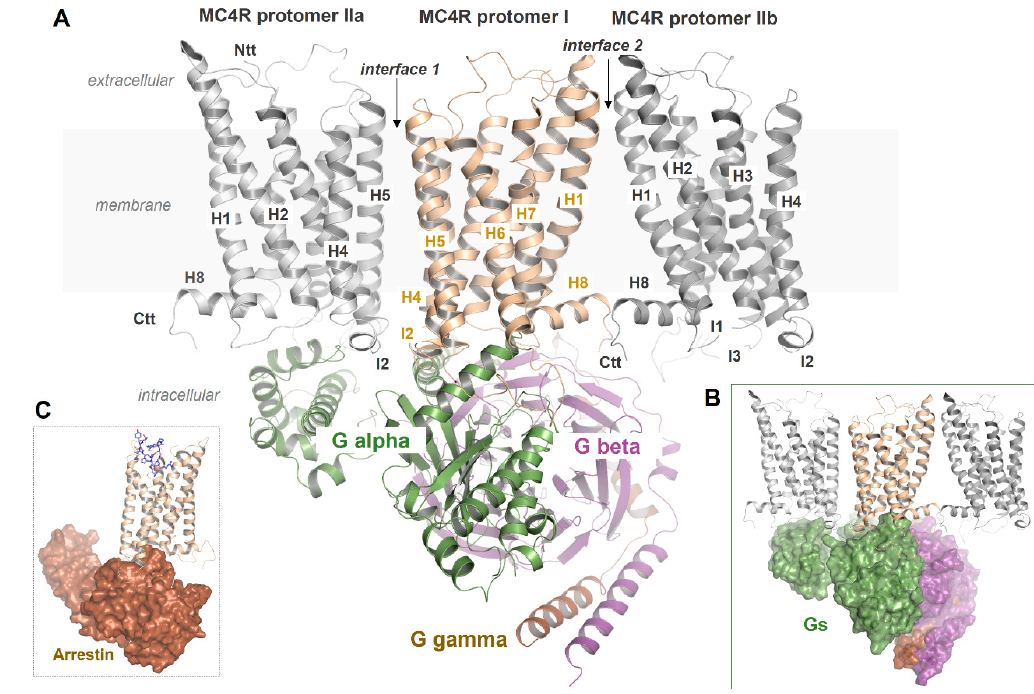
Figure 8. Putative MC4R dimer or oligomer constellations with bound G protein. A : The MC4R can represent dimers at the IL2–TMH4 interface; however, other interfaces, such as the TMH1–helix 8 interface, cannot be excluded for oligomers. In the supposed arrangement of an interface between IL2 and TMH4, for steric reasons, only one G protein molecule can likely bind ( B ). It remains unknown how MC4R oligomerization a ff ects β -arrestin binding ( C ) or how receptor protomers in oligomers di ff er from each other in their ligand binding kinetics through mutual influence, or how they react to simultaneously available arrestin and G protein